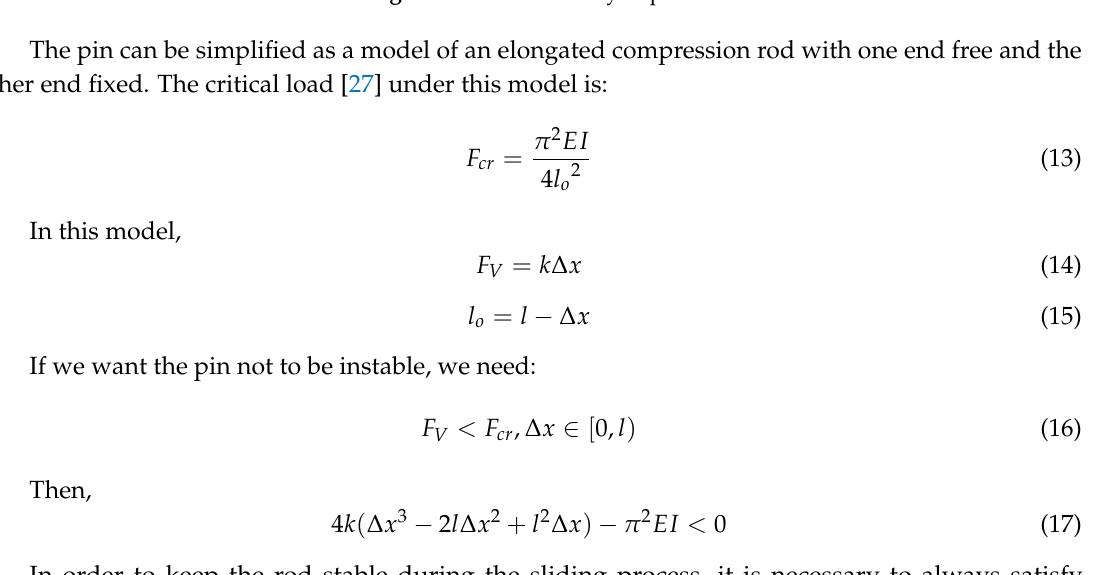
Figure 12. The instability of pin.